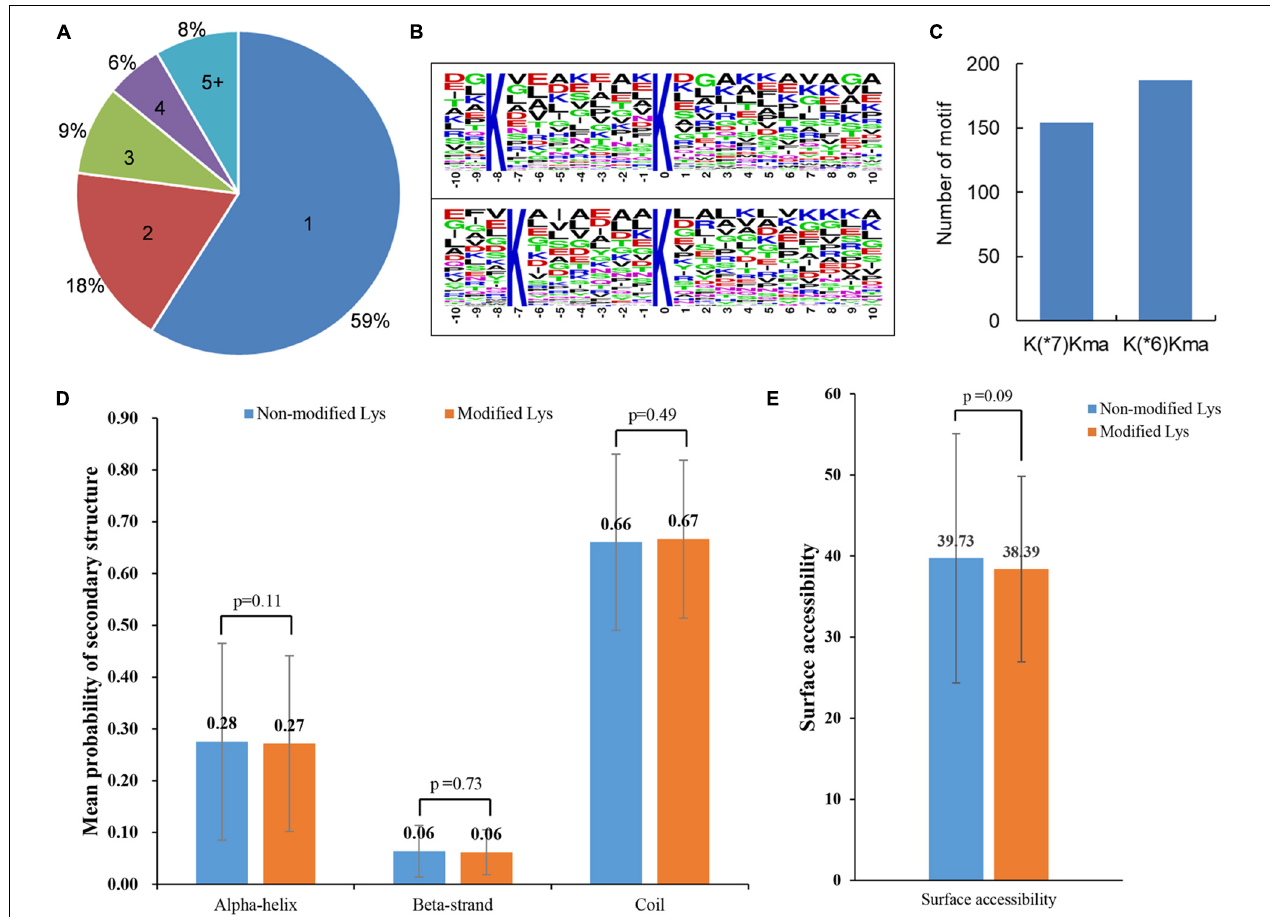
FIGURE 2 | Properties of modified peptides in maize. (A) A pie chart of the percentage and number of the modified sites for each identified malonylproteins. (B) Enriched sequence motifs containing ± 10 amino acids around the modified sites. (C) Number of enriched sequence motifs. (D) Mean probability of secondary structure. Wilcoxon test was used to measure the p -values. (E) Surface accessibility of modified lysine. The p -values were calculated with Wilcoxon